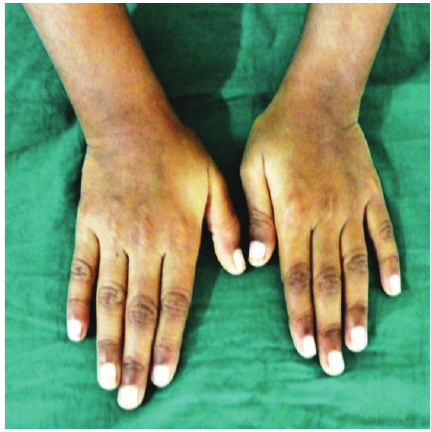
Figure 3: Showing no signs of widening of metaphysis.